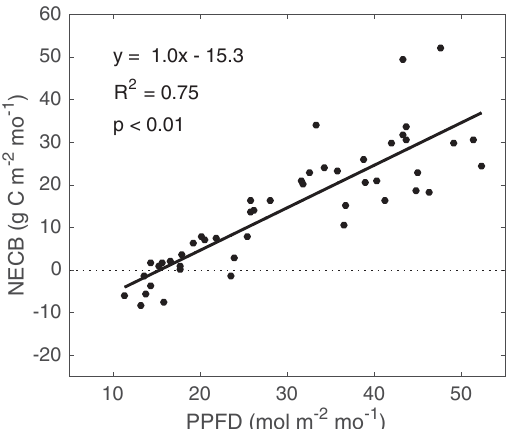
Figure 6. Monthly net ecosystem carbon balance (NECB) at Kopu- atai bog as a function of monthly total PPFD from January 2012